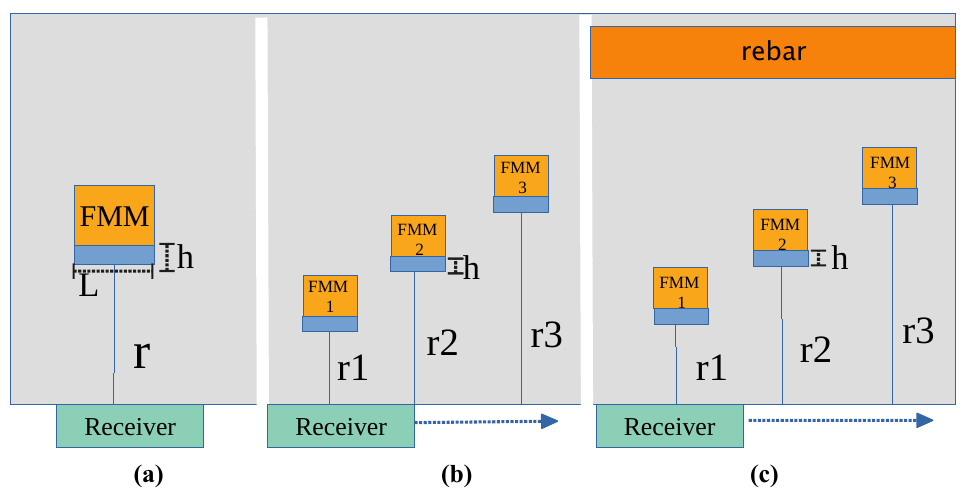
Figure 4. Numerical modeling diagrams: ( a ) Configuration 1 with a single FMM sensor, ( b ) Configu- ration 2 with three FMM tools in concrete, and ( c ) Configuration 3 with three FMM tools in concrete (including